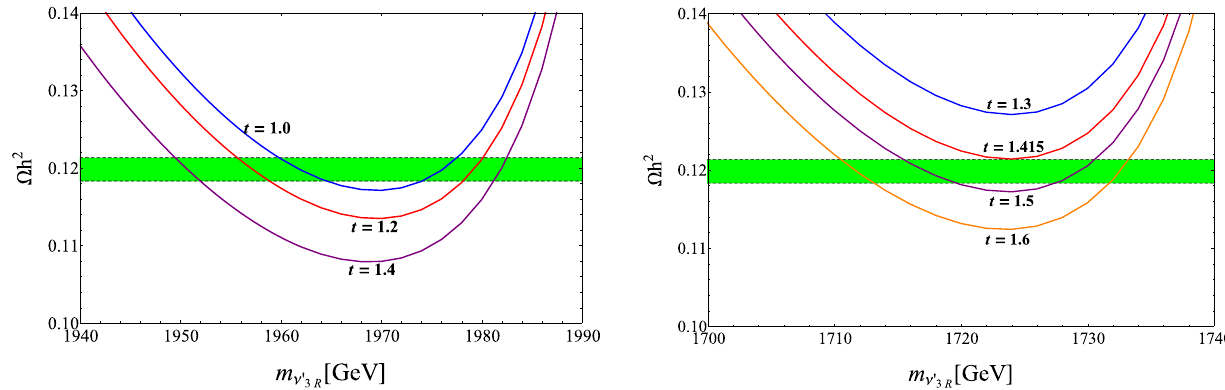
Fig. 3 The DM-neutron cross-section as a function of M Z (cid:2) with (cid:9) M / 2. The blue, red, purple, orange, green, and brown curves m ν (cid:2) Z (cid:2) 3 R correspond to t = 0 . 2, 0 . 9, 1 . 8, 2 . 6, 3 . 4, and 4 . 0, respectively. The